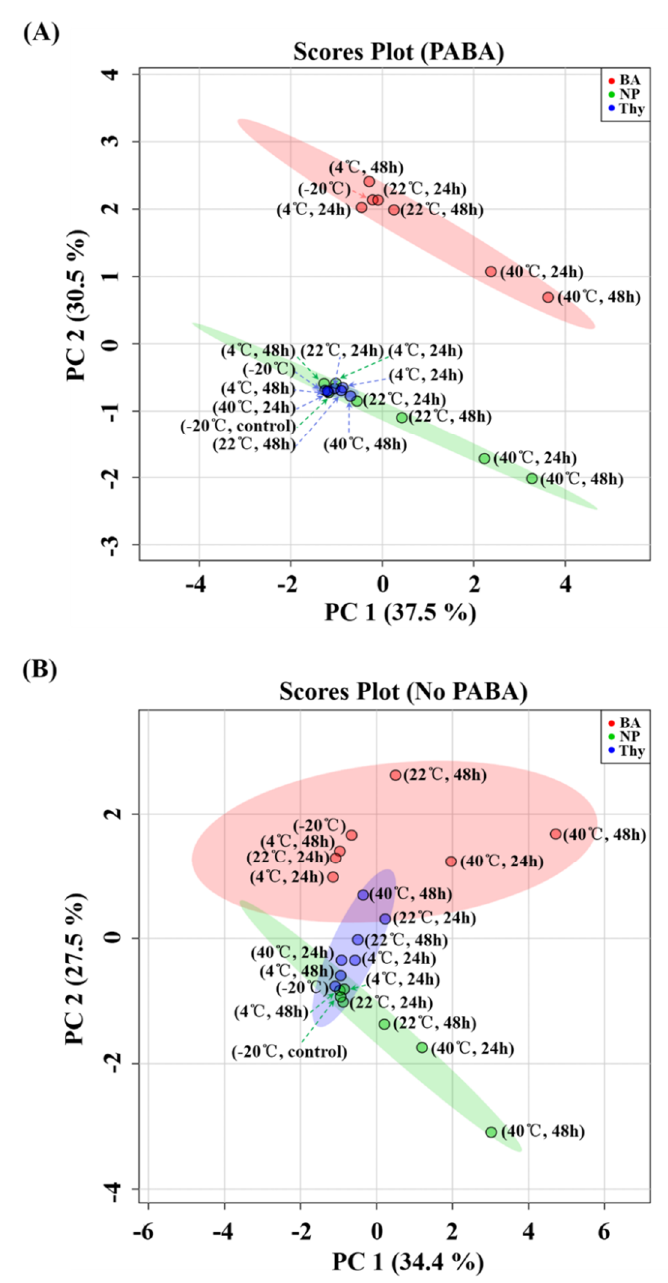
Figure 1. Principal component analysis (PCA) score plot of urine samples in ( A ) PABA group, and ( B ) No PABA group. Different colors represent different preservatives: green (no preservative), red (boric acid), and blue (thymol). Table 2. Effects of temperature and duration of storage on urine metabolites .